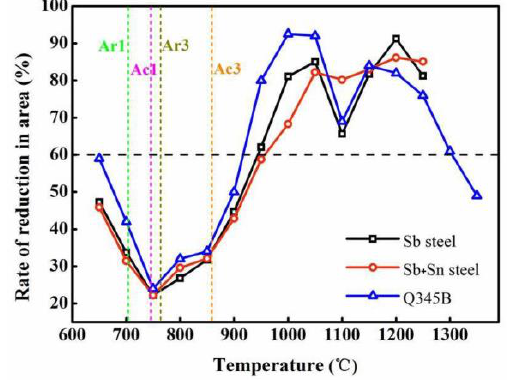
Figure 4. Hot ductility curves.